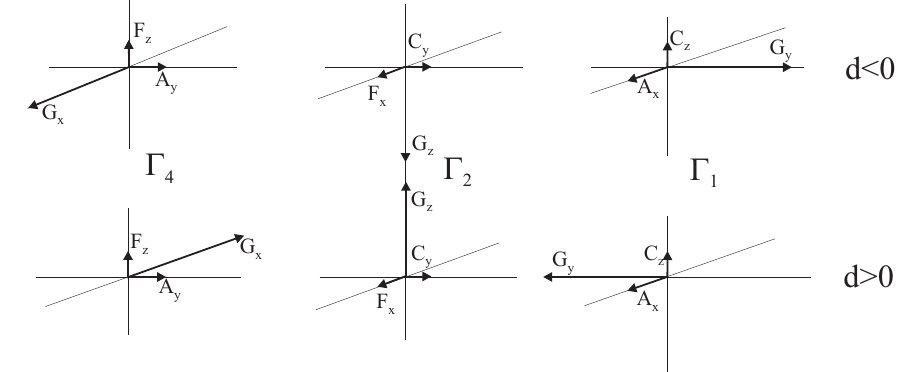
Figure 4. Basic vectors of magnetic structure for 3 d sublattice in orthoferrites and orthochromites Hereafter, we address the DM coupling for the S-type magnetic 3 d ions with orbitally nondegenerate high-spin ground state in a strong cubic crystal field—that is, for the 3 d e 2 e 2 ions with half-filled shells t 3 , t 3 , t 6 and ground states 4 A 2 g , 6 A 1 g , 3 A 2 g , g g 2 g 2 g 2 g